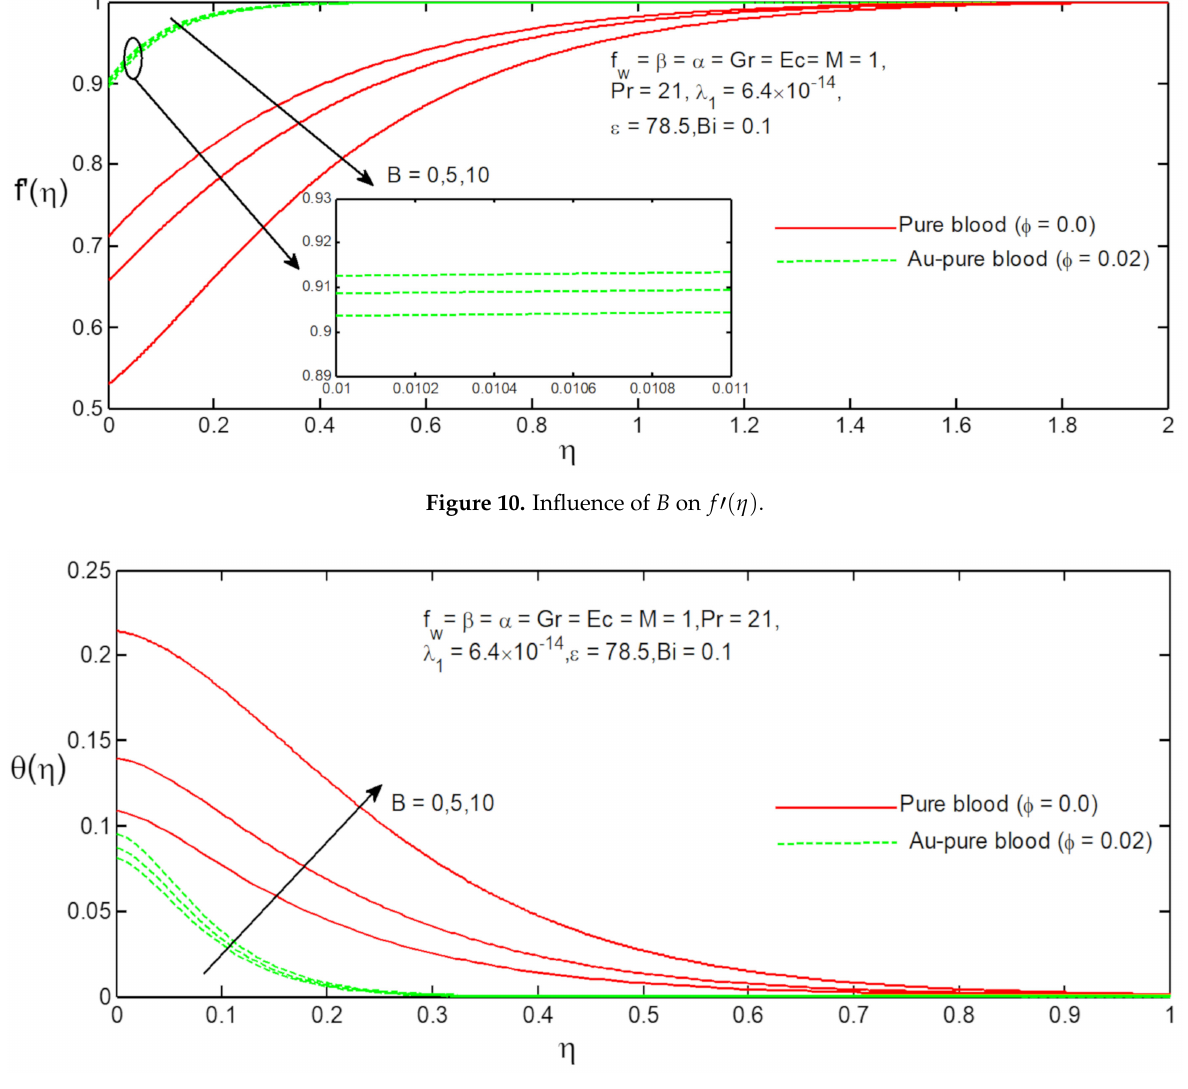
Figure 11. Influence of B on θ ( η )